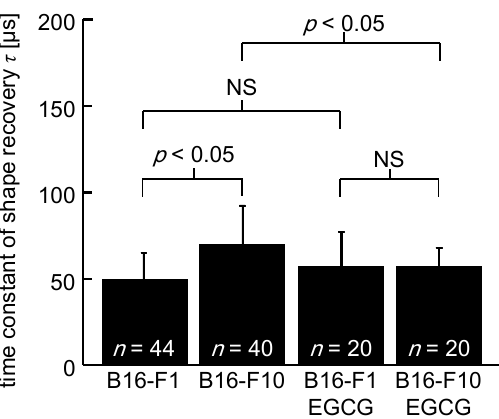
Figure 6. A comparison of the time constant of shape recovery τ . n : Number of cells.